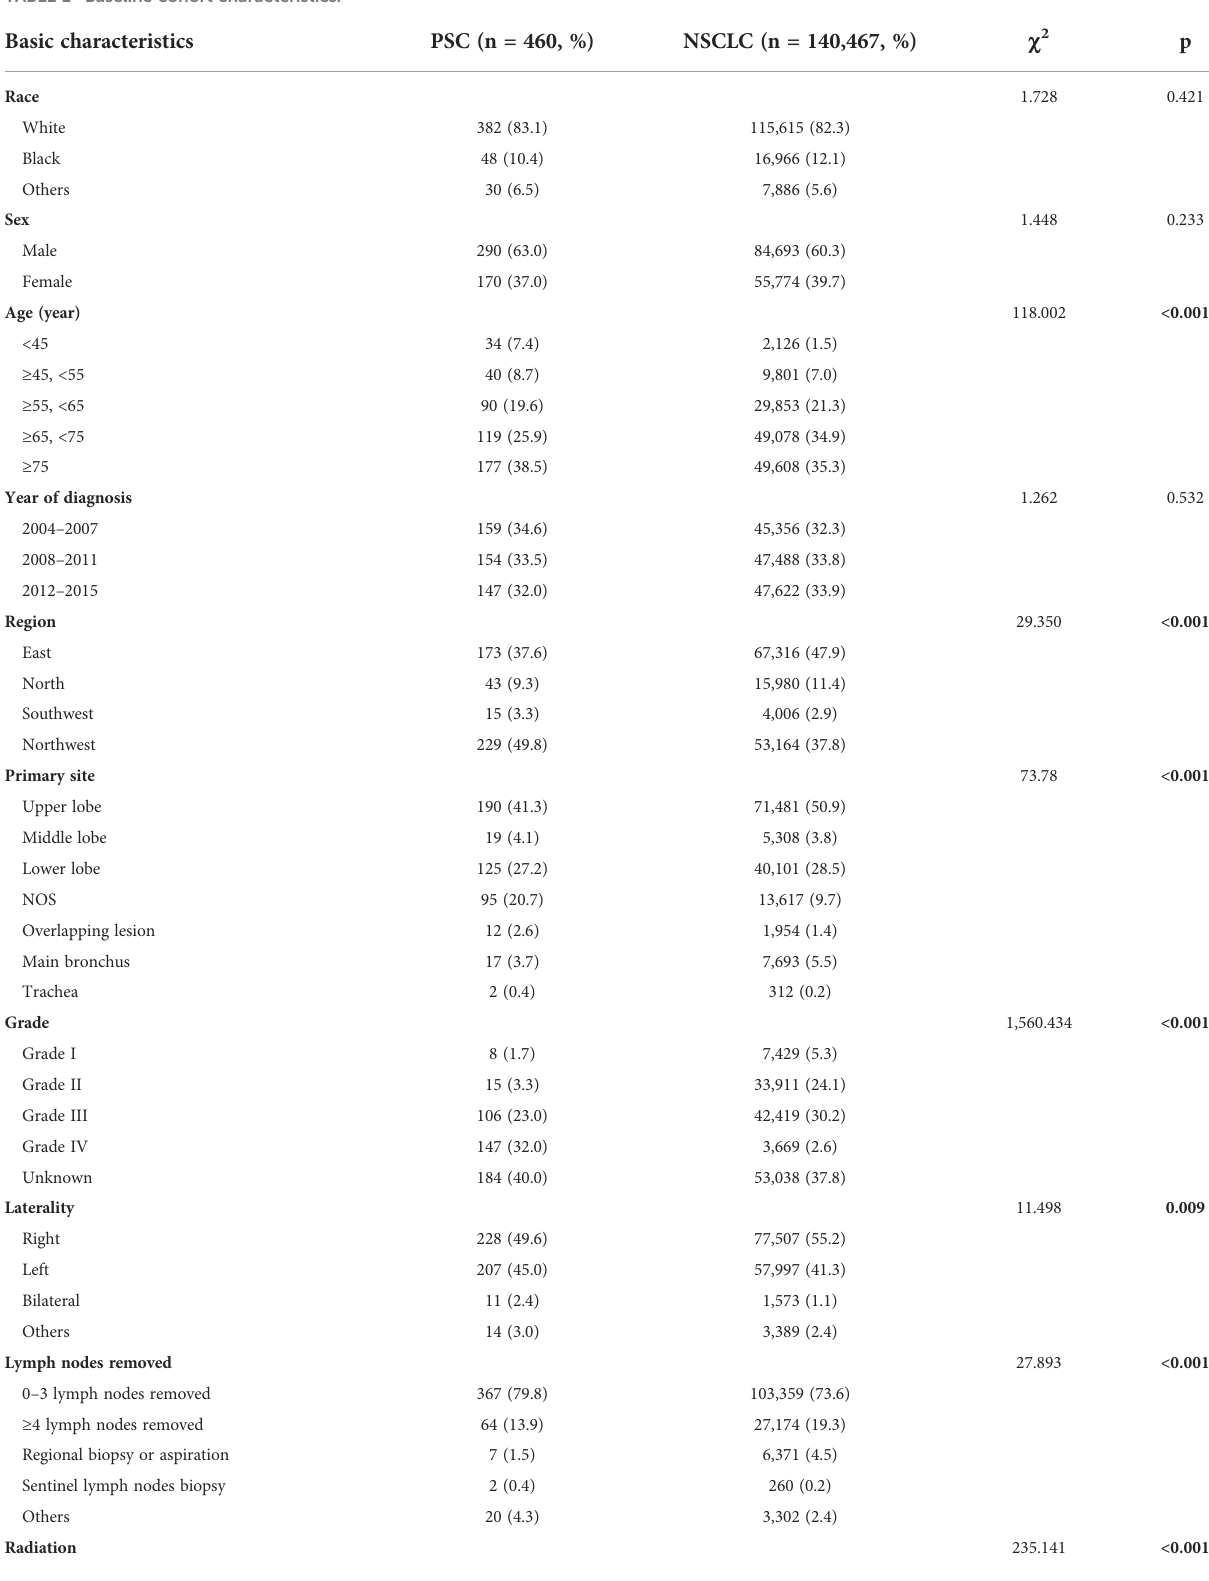
TABLE 1 Baseline cohort